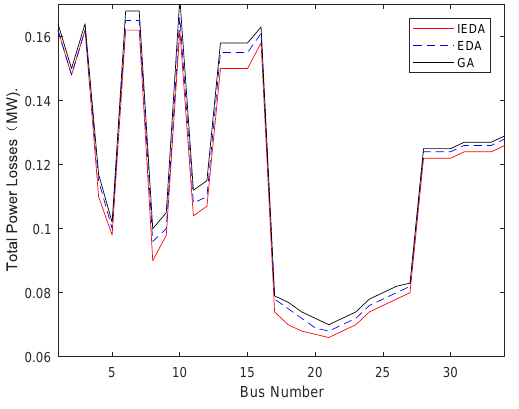
Figure 10. Distribution of network loss of each bus in the 34 bus radial distribution